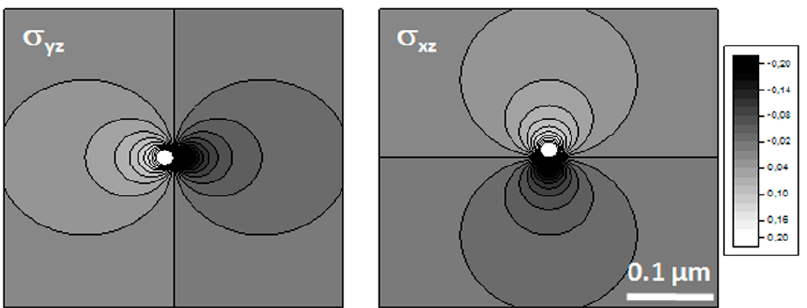
Figure 1. Plots of the stress components σ yz ( a ) and σ xz ( b ) of a screw dislocation. The stress outside the dislocation core reaches values up to about 200 MPa. The scale shows the stress in GPa.